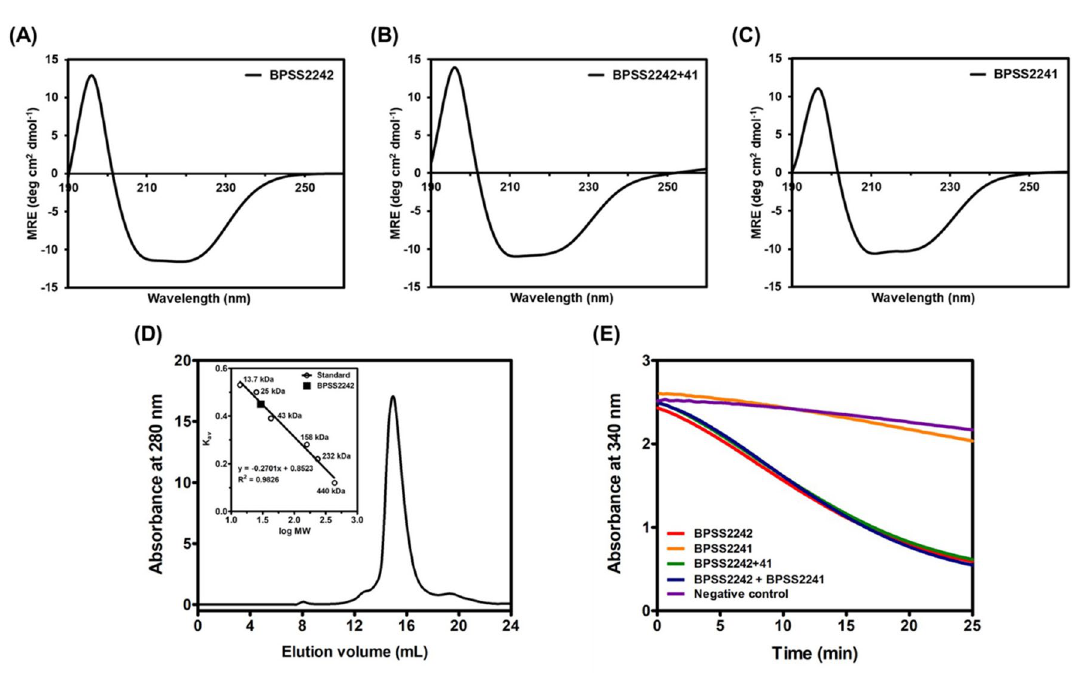
Figure 3. Analyses of purified recombinant proteins. CD spectra of ( A ) BPSS2242, ( B ) BPSS2242 + 41, and ( C ) BPSS2241. ( D ) The standard curve and gel filtration chromatogram for determining native state of BPSS2242. ( E ) Diacetyl reductase assay of BpSDRs. Negative control is the reaction without